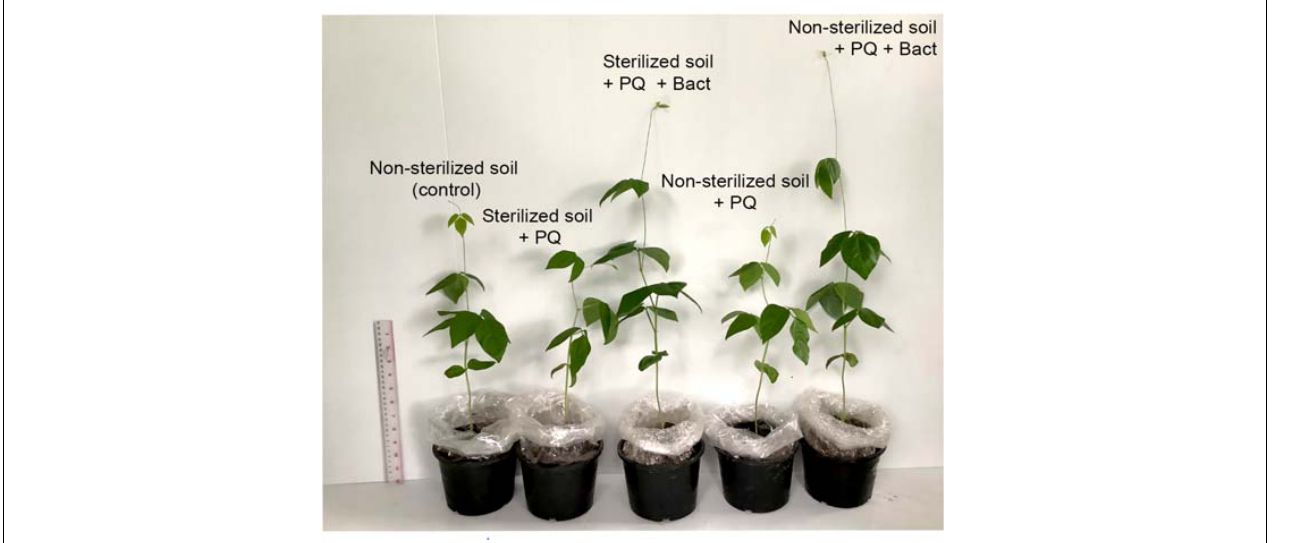
FIGURE 7 | Growth of cowpea ( V. unguiculata ) (6 weeks age) in soil with/without paraquat in the pot experiment.